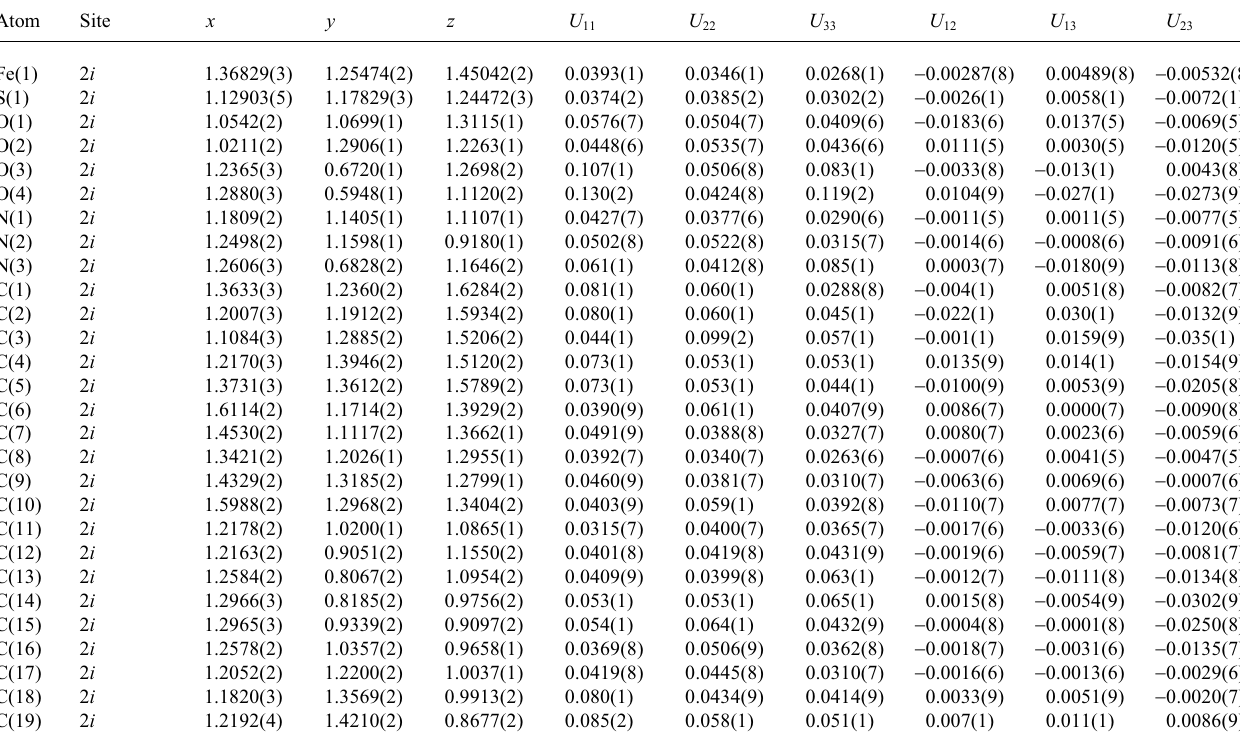
Table 3. Atomic coordinates and displacement parameters (in Å 2 )